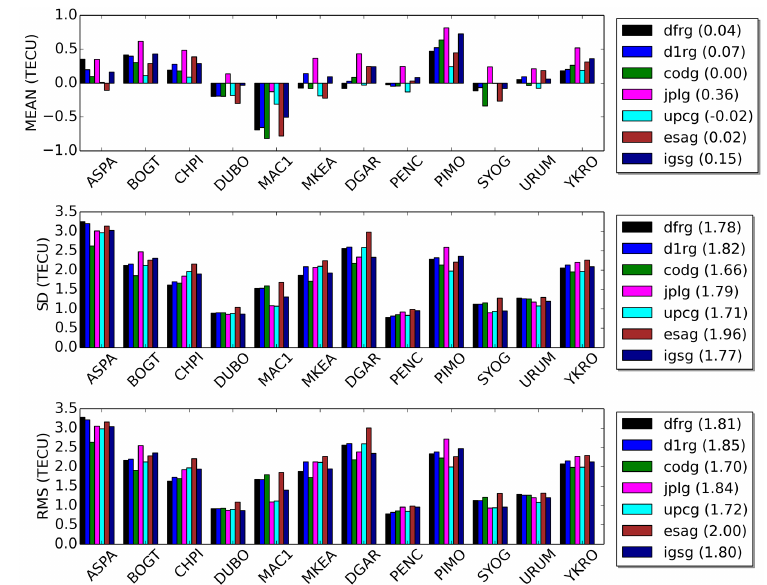
Figure 6. Results of the statistical evaluations presenting the differences between the observed and computed dSTEC values, which cover the days between DOY 224 and DOY 238, 2016: (upper panel) mean of deviations, (middle panel) standard deviations and (bottom panel) RMS values of deviation in terms of TECU.